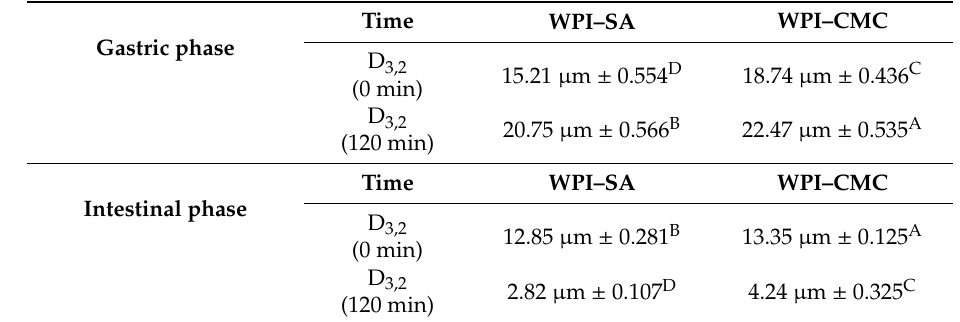
Table 1 . Particle size for whey protein isolate with sodium alginate (WPI–SA) and whey protein isolate with sodium carboxymethylcellulose (WPI–CMC) systems at the beginning (0 min) and end (120 min) of gastric and intestinal digestion (pH 2.5).